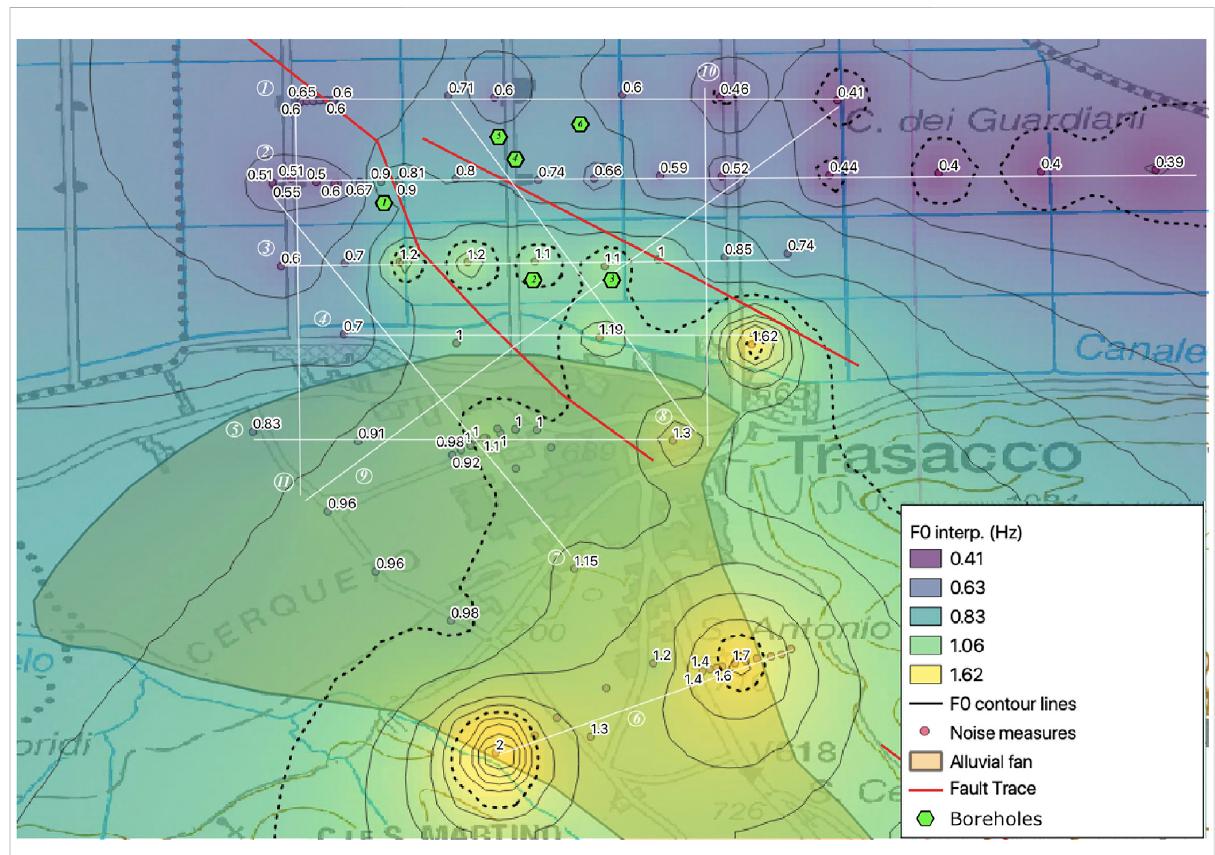
FIGURE 4 Map of f0 interpolation. Red dots represent the noise measurements with the f0 value reported. The fault lines in red come from the ITHACA database. Green diamonds represent the boreholes considered for 1D modeling (Figure